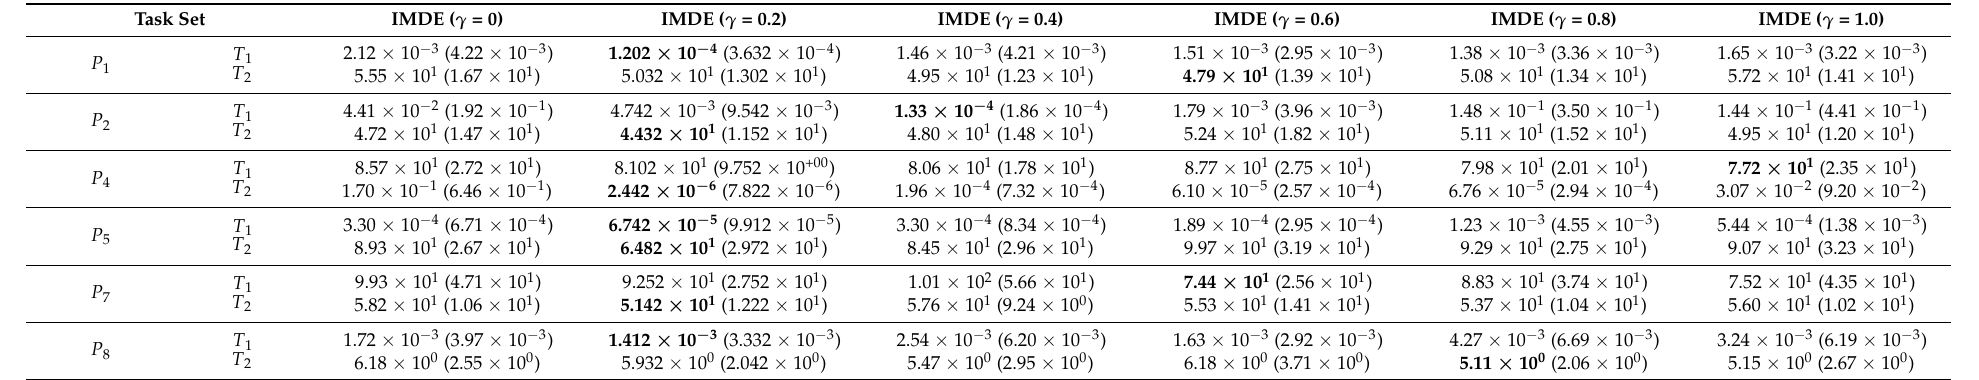
Table 3. The mean and standard deviation (in brackets) of the best achieved fitness values of IMDE with different randomly chosen